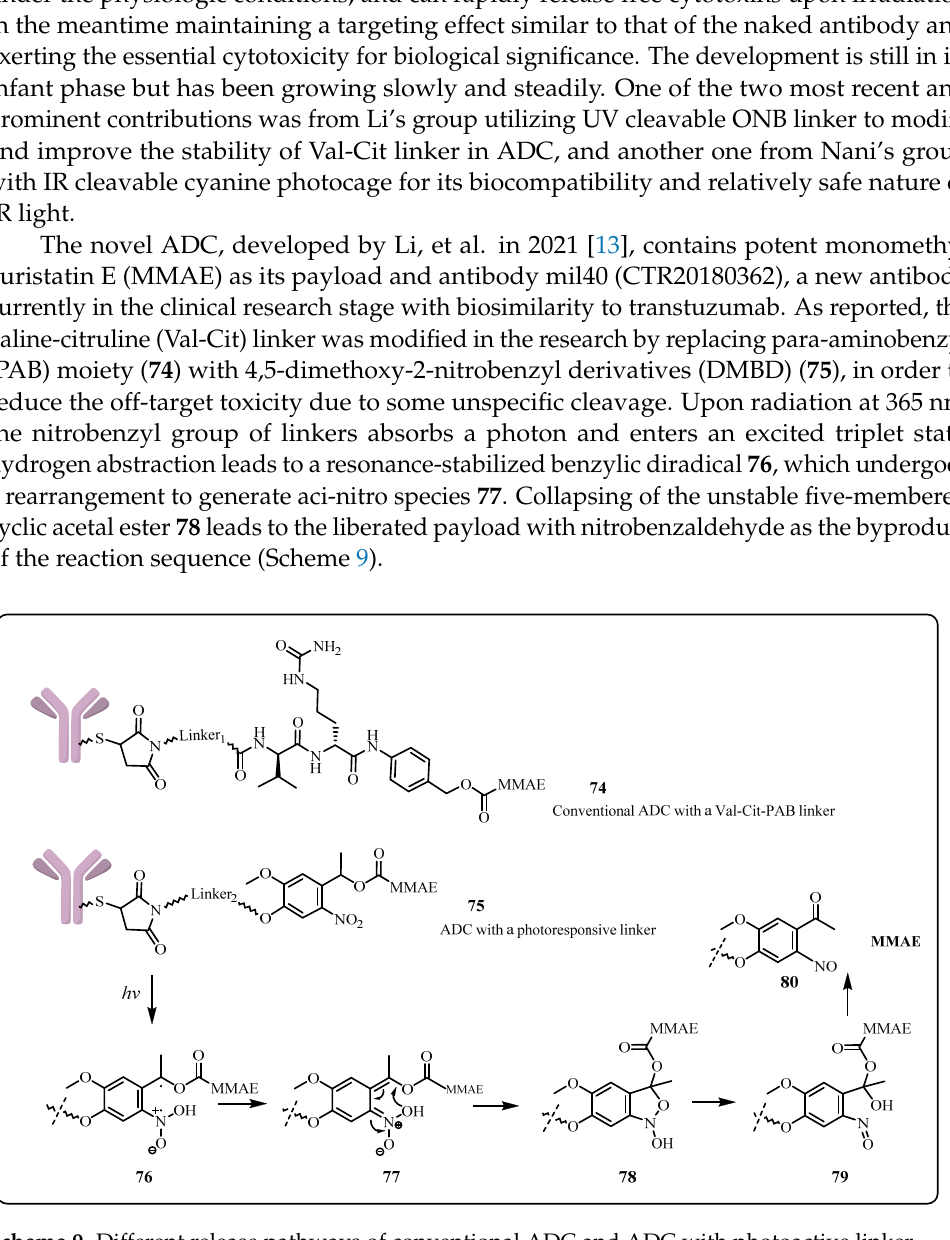
Figure 10. First and second generations of ADC containing cyanine photocage linkers. Light ‐ controlled linker with its internal stability and good pharmacokinetic proper ‐ ties exhibits a great application potential in the development of future ADC, as reviewed above. The irradiation activation can be conveniently achieved by using fiber optic or en ‐ doscopic probes to transmit the required light to the site of action or directly by irradiating the lesion during surgery. This external trigger mechanism provides a favorable option to circumvent the intrinsic problems of the conventional conjugate, such as off ‐ target tox ‐ icity, poor therapeutic index, etc. In the meantime, it allows more possible manipulations in the development to improve the potency and pharmacokinetic properties. Further in ‐ vestigations are going to focus on the optimization of the photocleavable linker structures